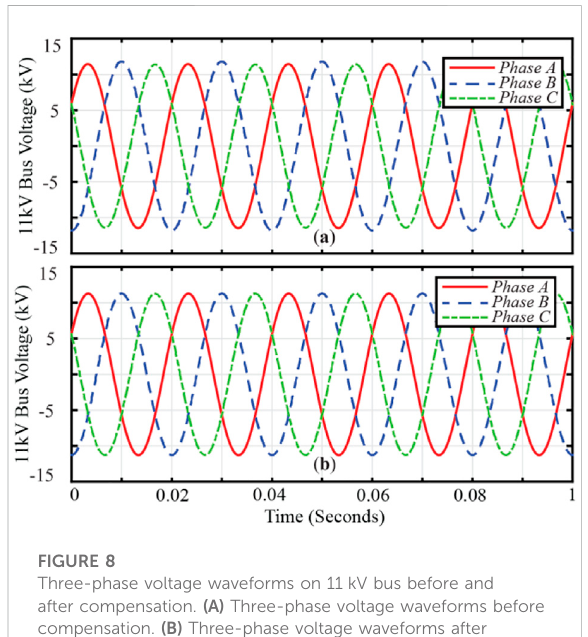
FIGURE 8 Three-phase voltage waveforms on 11 kV bus before and after compensation. (A) Three-phase voltage waveforms before compensation. (B) Three-phase voltage waveforms after